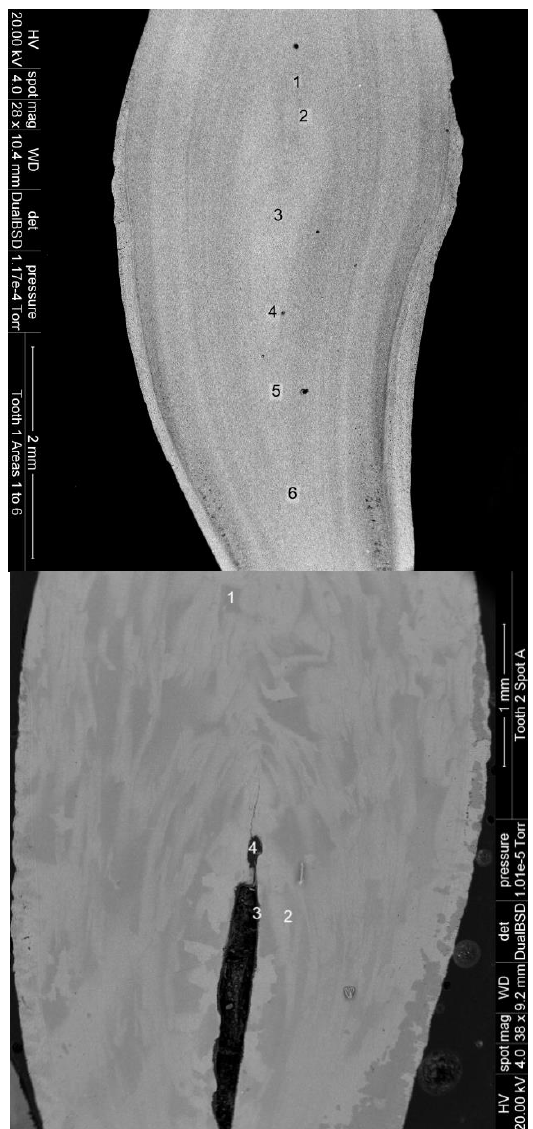
Fig. 4. Sampling locations of calcium and phosphorus in cross sections of teeth from (a) Shona and (b) Kelly . See Table 3 for weight percentage values measured using energy-dispersive